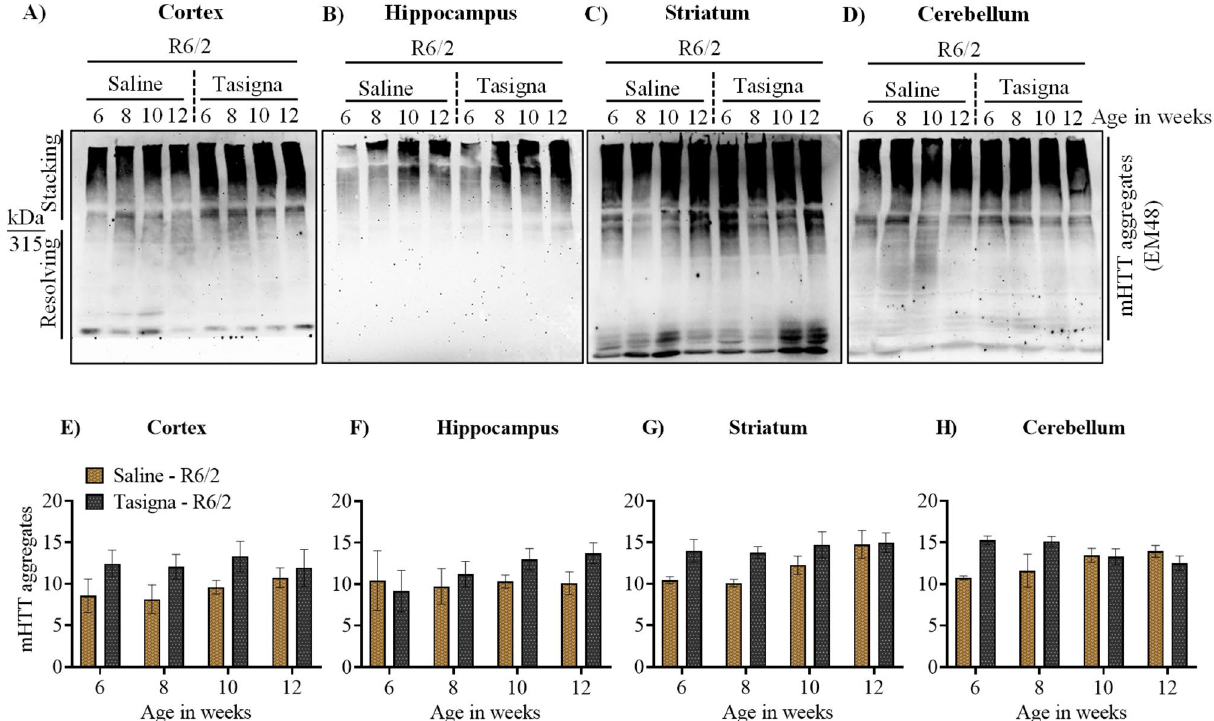
Figure 7. Nilotinib (Tasigna™) is ineffective in enhancing the clearance of mHTT aggregates at any given stage of disease progression in R6/2. ( A )–( D ) Representative immunoblot showing no effect of Tasigna in clearing mHTT aggregates (EM48) from 6, 8, 10, and 12 weeks in the cortex, Hippocampus, striatum and cerebellum, respectively. ( E )–( H ) Pooled quantified bar graphs for mHTT aggregates for cortex: Age x treatment (F (3,12) = 0.26, p = 0.84), hippocampus: Age x treatment (F (3,12) = 0.49, p = 0.69), striatum: Age x treatment (F (3,12) = 1.27, p = 0.32) , and cerebellum Age x treatment (F (3,12) = 4.603, p = 0.02). N = 3 (R6/2-Saline), and (R6/2-Tasigna) for all the 4 age groups 6, 8, 10, and 12 weeks. Error bars indicate ± SEM. (Mean and ± SEM values are represented in supplementary Table 6). N = number of mice. The treatment groups are separated by vertical dashed lines. Statistical analysis was done by Two-way ANOVA followed by Bonferroni post-hoc test. Image brightness and contrast were adjusted for representative purpose. Blots with different exposures and full uncropped raw blots are represented in the supplementary Figs. S4 and S12,